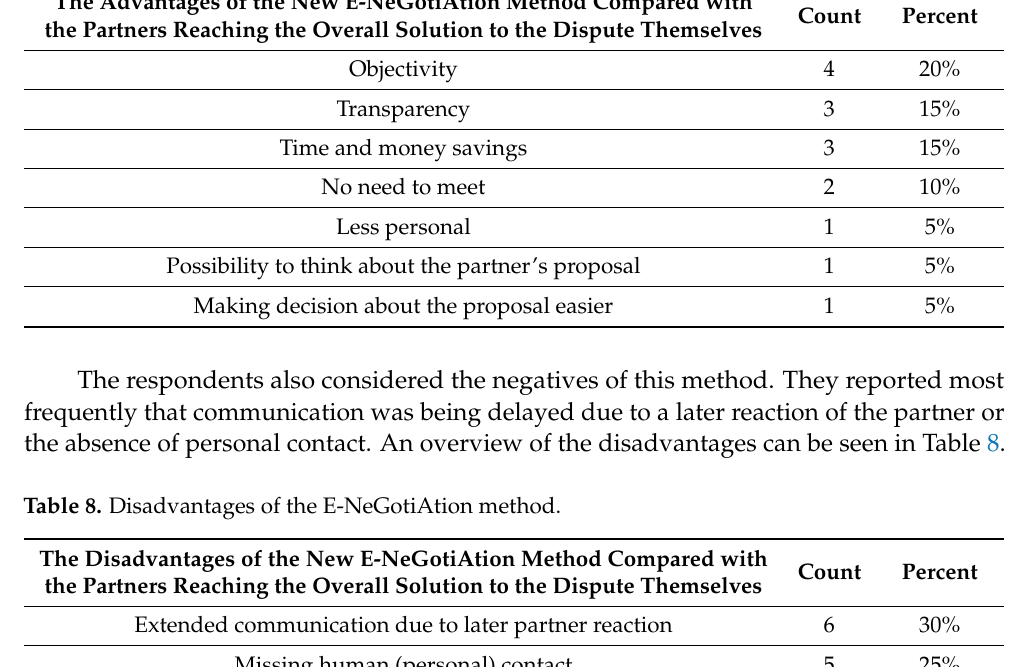
Table 7. Advantages of the E-NeGotiAtion method.